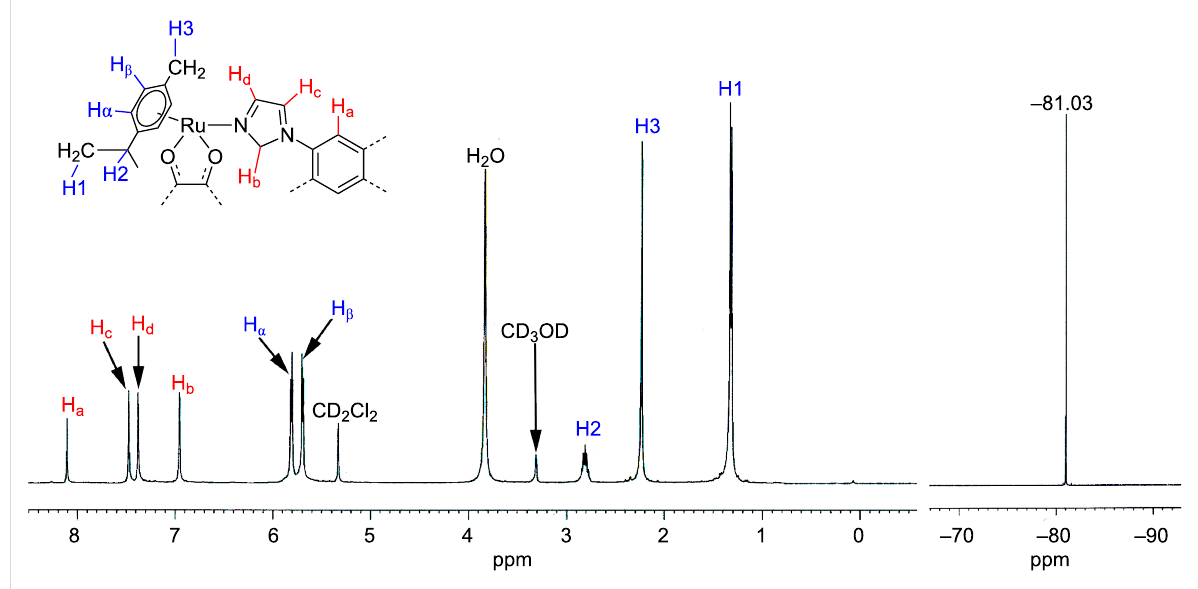
Figure 1: 1 H (left) and 19 F (right) NMR spectra of tetranuclear macrocycle 2a recorded in CD 2 Cl 2 –CD 3 OD with peak assignments.